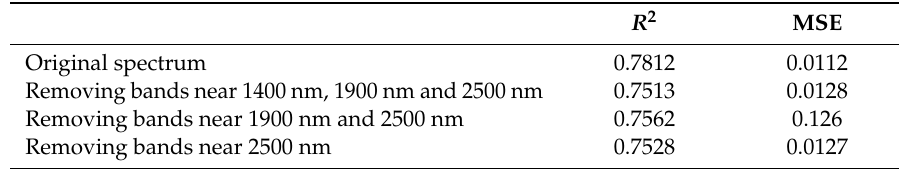
Table 7. Comparison results of removing some bands from the original spectra (coe ffi cient of determination, R 2 ; mean square error,